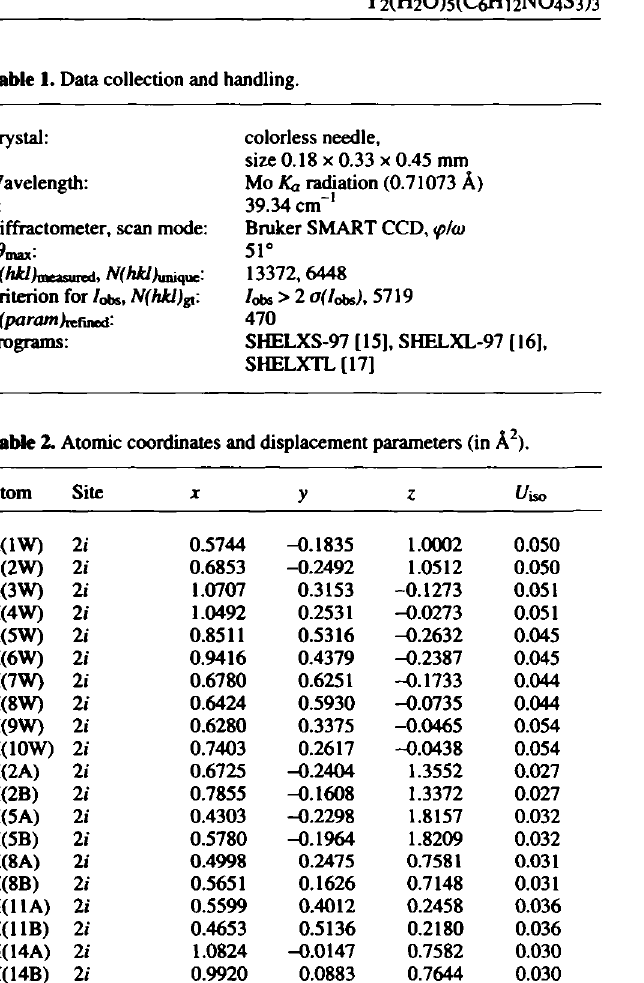
Table 3. Atomic coordinates and displacement parameters (in Â 2